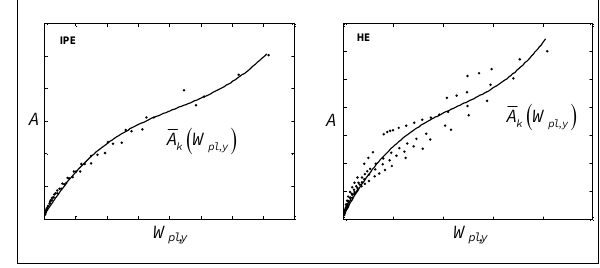
Fig. 7. Approximative mean curves of IPE and HE profiles Table 1. Ratios of approximative